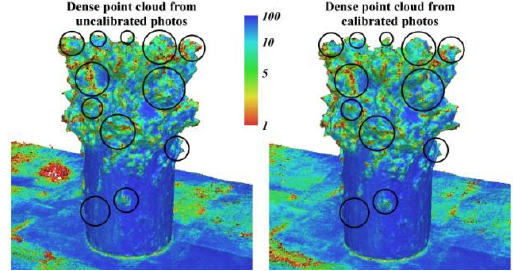
Figure 6. Reliability comparison between the dense point clouds of the vase. Improved parts are circled in black.